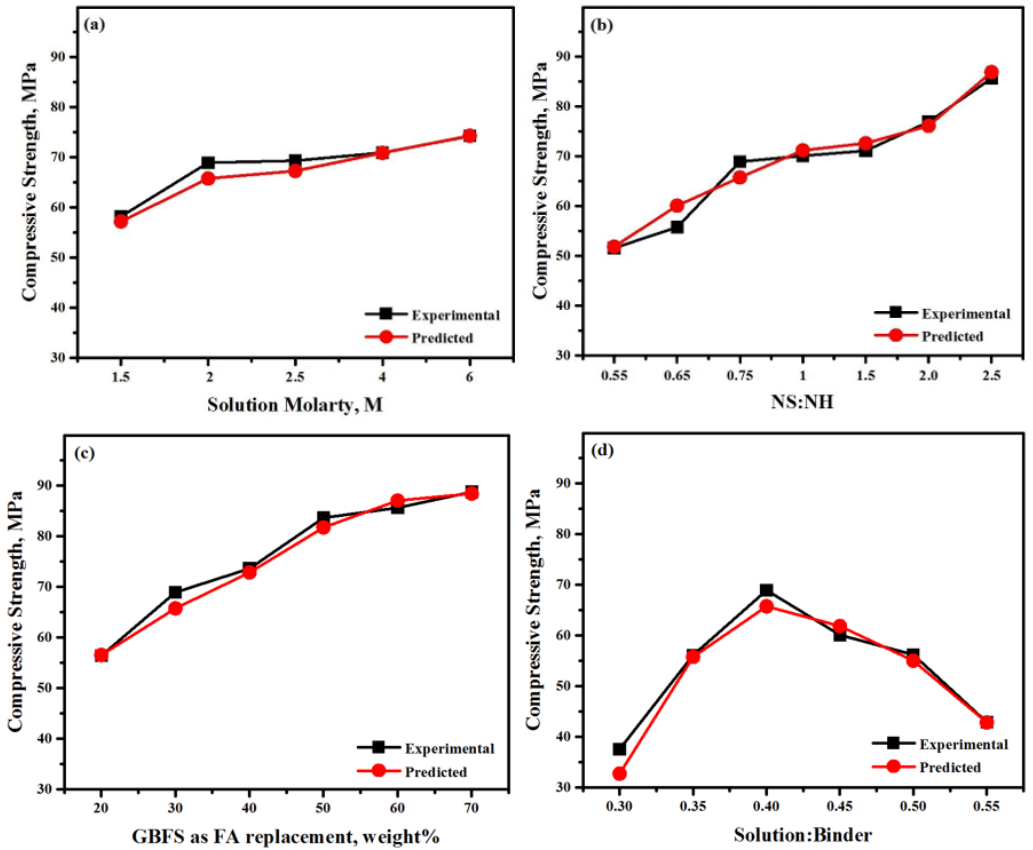
Figure 14. Predicted and actual evolution of alkali-activated strength as a function of ( a ) molarity, ( b ) NS/NH, ( c ) FA/GBFS, ( d ) and solution to binder ratio .